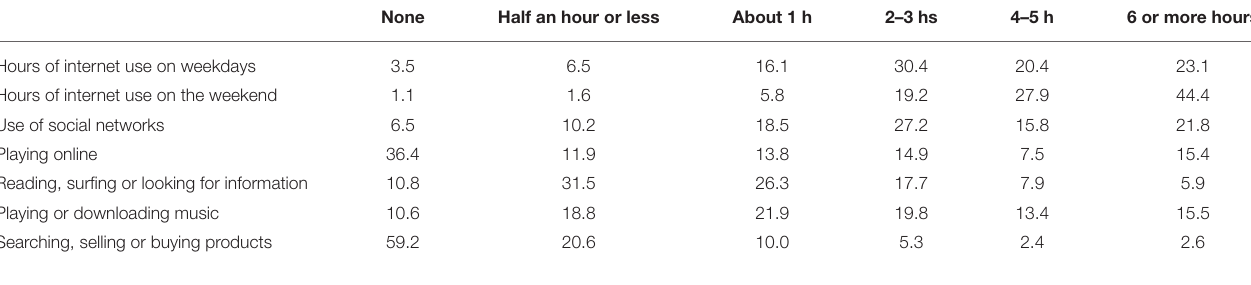
TABLE 1 | Descriptive statistics of variables about the frequency of Internet use.